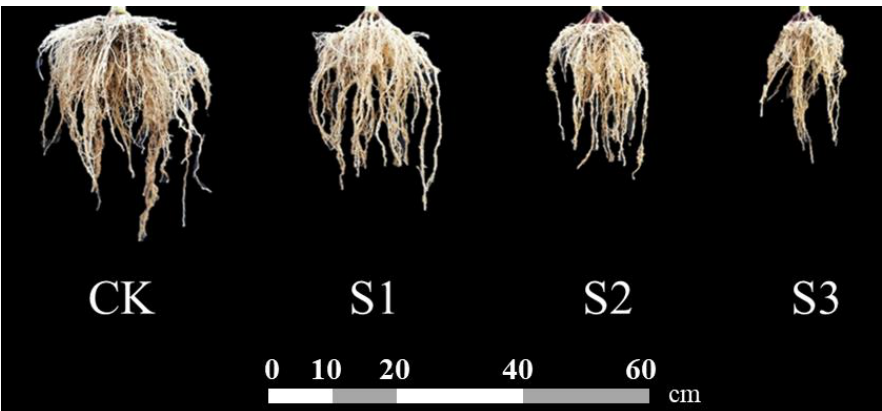
Figure 8. Maize root of DH618 under different shading level (CK: natural light control; S1: 15% shading; S2: 30% shading; S3: 50% shading) at D2 (12 × 10 4 plants ha −1 ) planting densities at the silking stage.